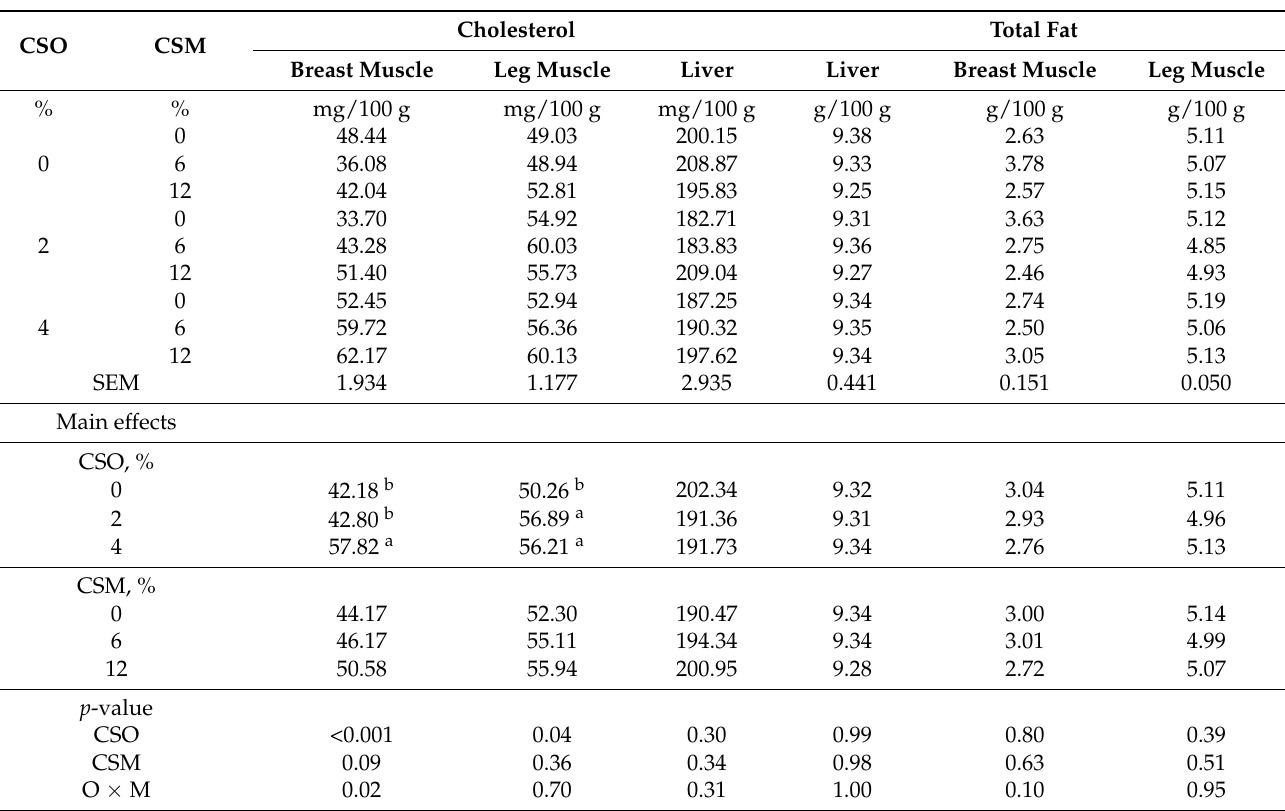
Table 5. Effects of cottonseed oil (CSO) and cottonseed meal (CSM) on cholesterol and fat content of different tissues in laying hens 1